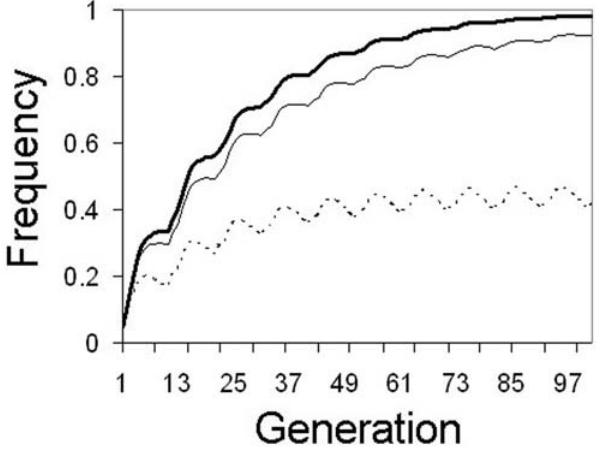
Figure 5. Discontinuous release. Changes in transgene frequency with a 5% release every 10 generations of mosquitoes homozygous for a transgene at 4 unlinked loci (8 copies/genome). Thick solid line: no fitness cost ( F =1.0), thin solid line: 1% fitness cost/insert ( F =0.99), thin dotted line: 5% fitness cost/insert ( F =0.95).